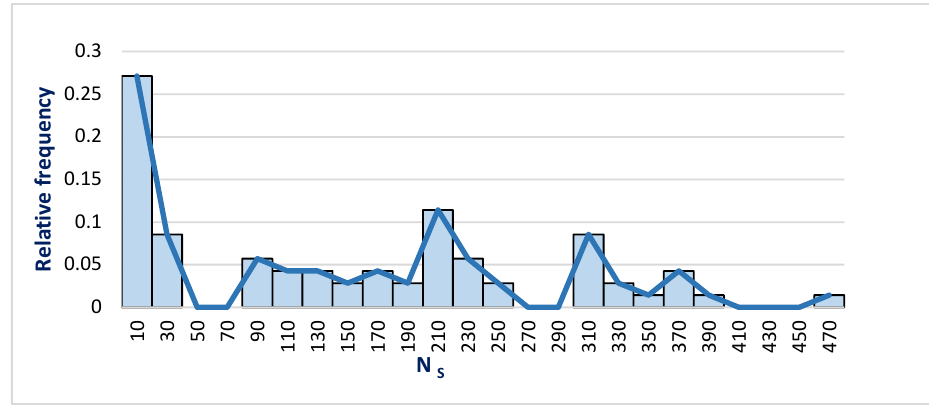
Figure 12. Histogram of the index P INV . Continuing with the characterization of the inverters, the N S indicator represents the number of strings per inverter. Once again, its histogram shows a high dispersion (Figure 13) attributed to the dependence of this indicator on the strategy used to define the number of inverters in the installation. Despite this, it is found that the most common configuration has less than 20 strings per inverter, with a relative frequency of 27.14%. This relative frequency exceeds by more than double the relative frequency of any of the remaining classes considered for this indicator.